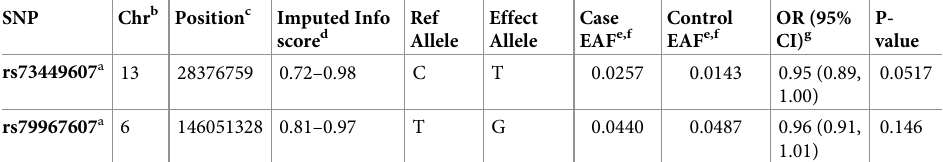
Table 4. The association between rs73449607 or rs79967607 and type 2 diabetes in the Population Architecture Genomics and Epidemiology/DIAbetes Genetics Replication and Meta-analysis (PAGE/DIAGRAM) study.